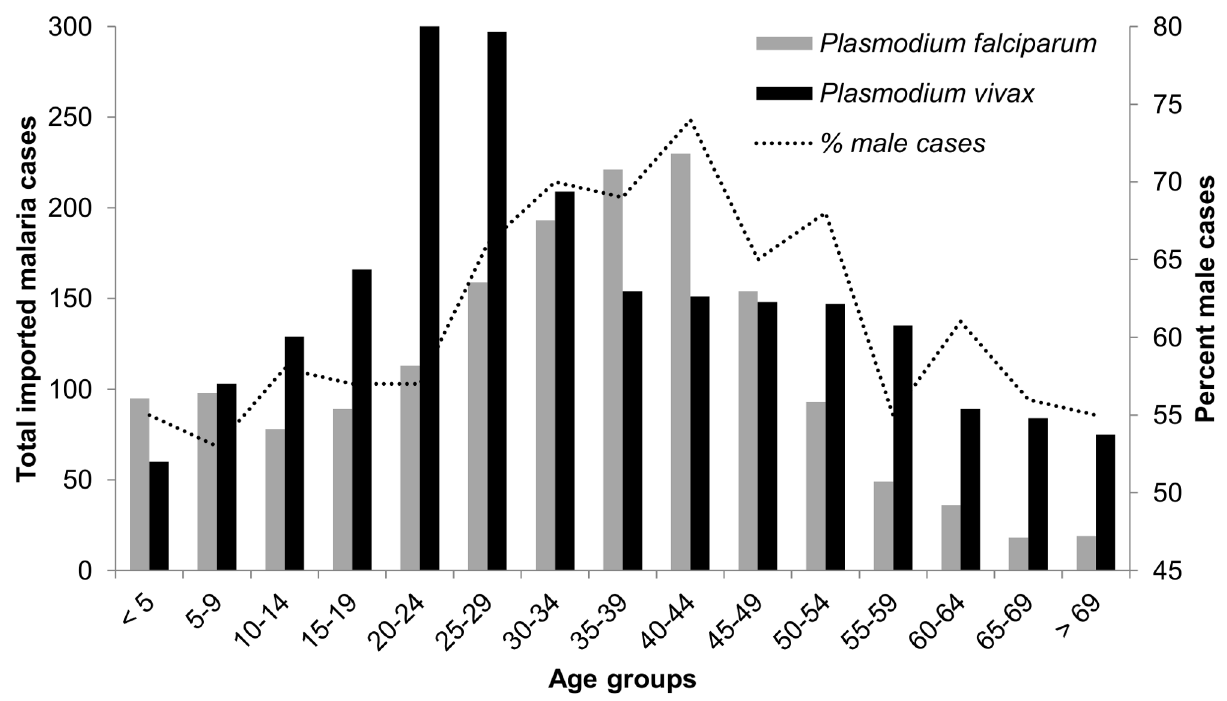
Figure 3. Plasmodium falciparum and Plasmodium vivax cases according to age at time of illness and percent male cases (all Plasmodium species) in Ontario, Canada (1990–2009) *. *For all Plasmodium species, the mean age at time of illness onset was 33.8 ± 0.26. There was no significant difference in mean age among Plasmodium species, P. falciparum (32.8 ± 0.39), P. vivax (34.0 ± 0.38), P. malariae (32.2 ± 2.25), and P. ovale (32.1 ± 1.27) (F = 1.9, p = 0.13). 3,4275 doi: